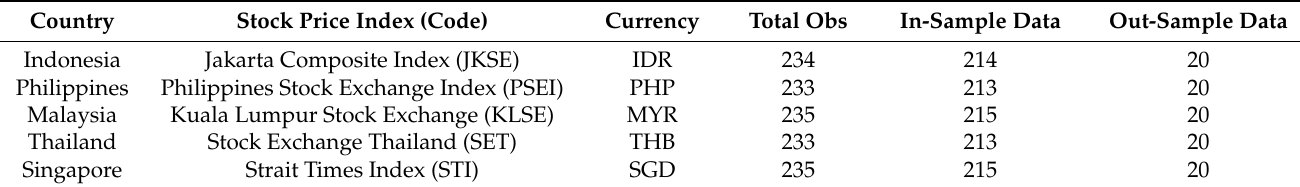
Table 1. General description for ASEAN-5stock price